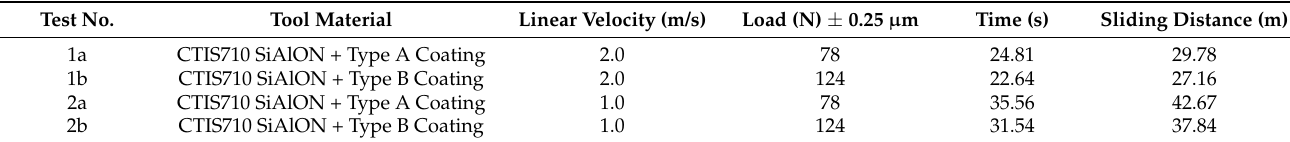
Table 2. Pin-on-disc test sliding distance results.